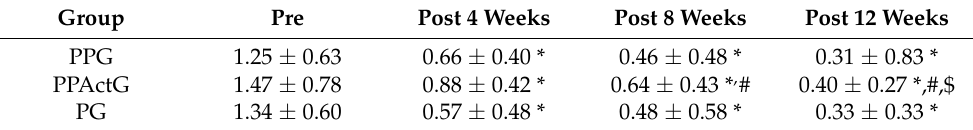
Table 4. Lost Urinary(g).